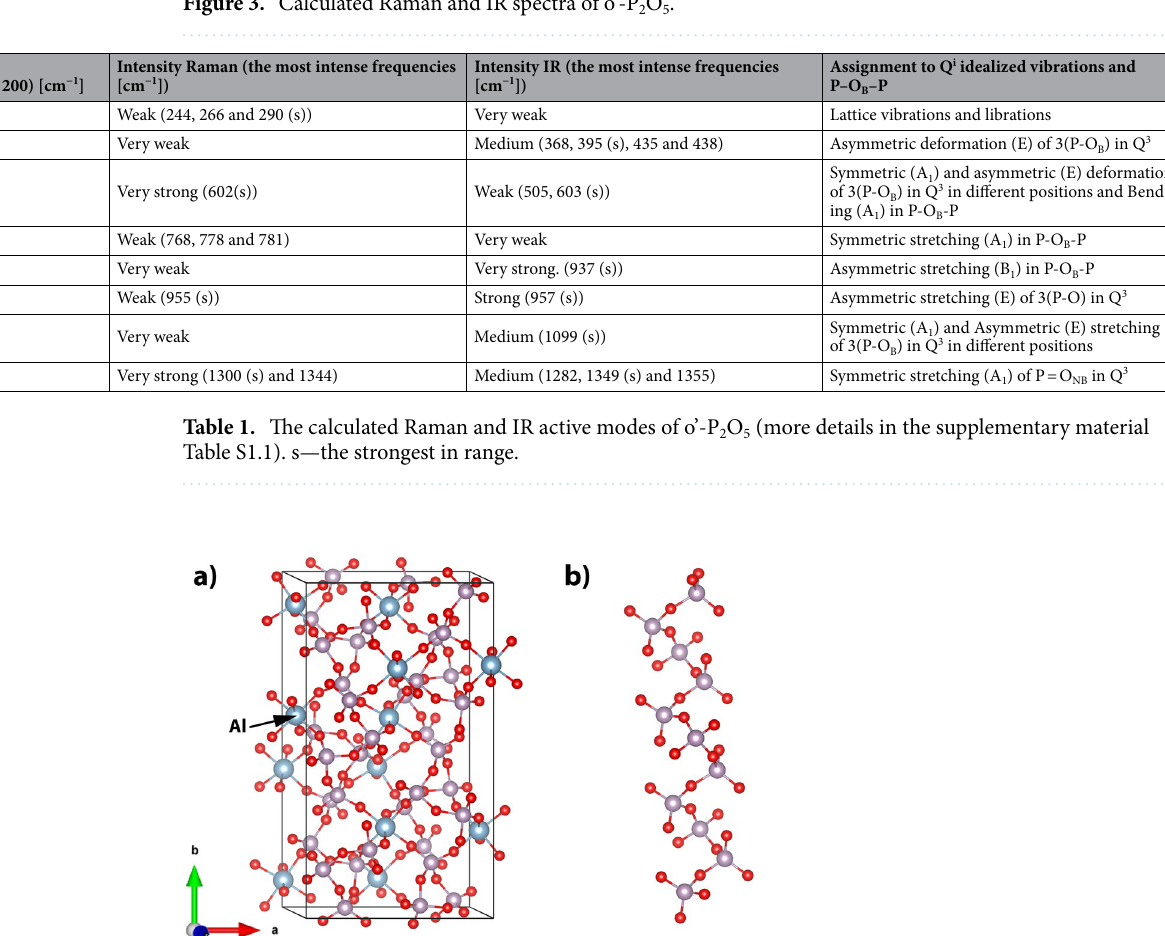
Figure 3. Calculated Raman and IR spectra of o’-P 2 O 5 .